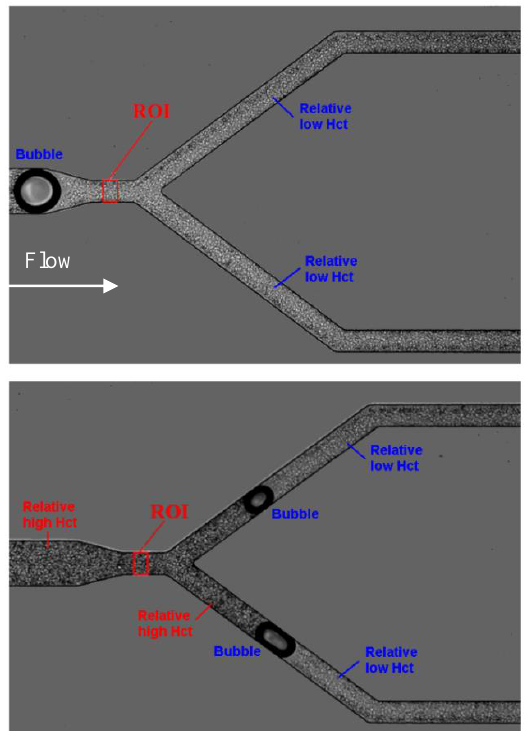
Figure 6. Influence of air bubbles on the local hematocrit (Hct) for a flow rate of 10 µL/min and 10% Hct at the first bifurcation (B1) (see Supplementary Video 2).